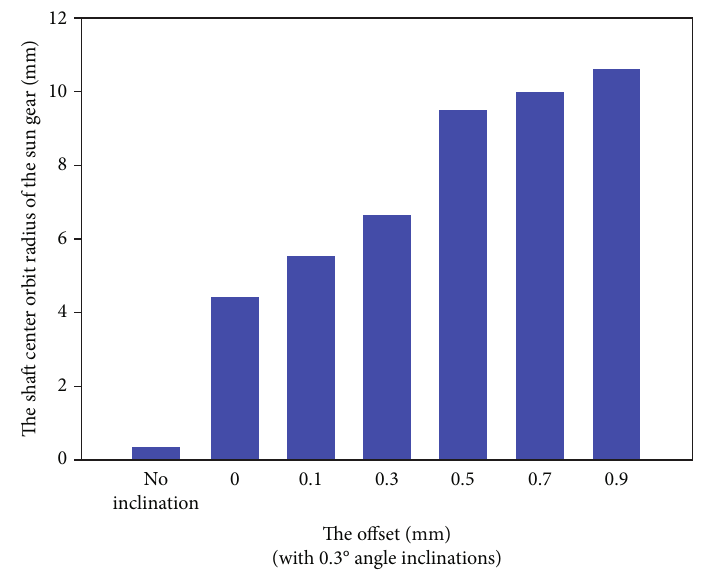
Figure 14: The variations in the shaft center orbit radius of the sun gear with di ff erent o ff